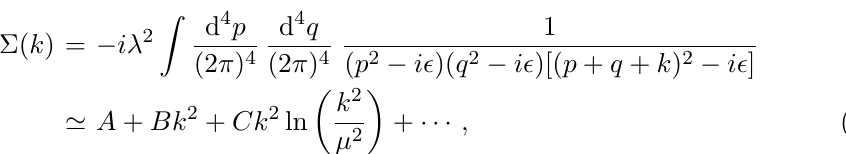
Figure 4 . Feynman graph giving a two-loop correction to the scalar propagator that is not pro- portional to the one-loop tadpole contribution of (cid:12)gure